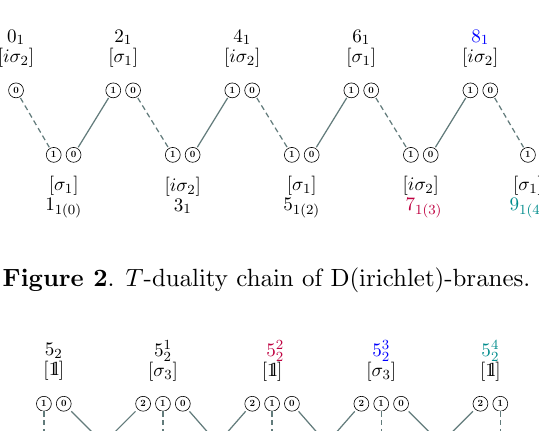
Figure 1 . T -duality chain of F(undamental)-branes.